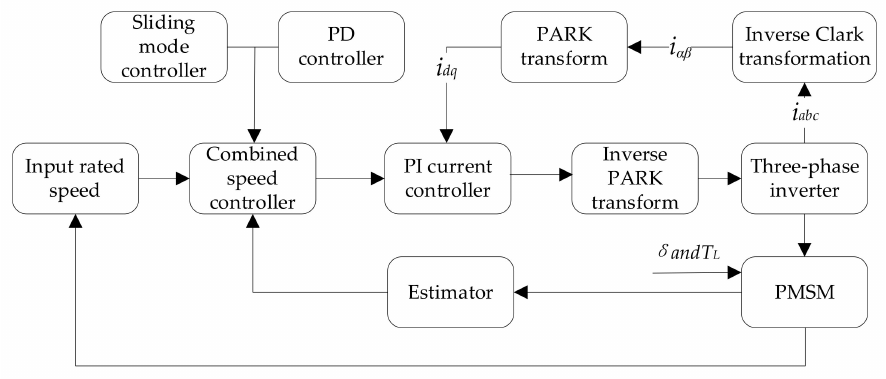
Figure 1. The speed control and estimator